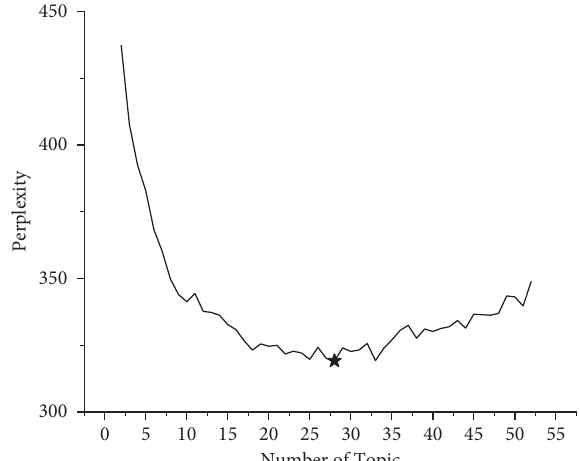
Figure 6: Perplexity of LDA topic models corresponding to different topic